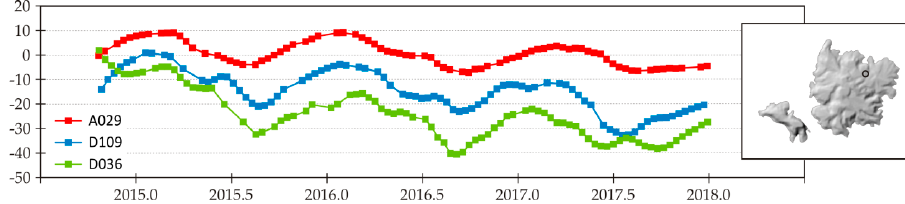
Figure 4. Temporal evolution of LOS displacements over selected PS target located on Nea Kameni, for the three Sentinel-1 acquisition geometries shown in Figure 2.